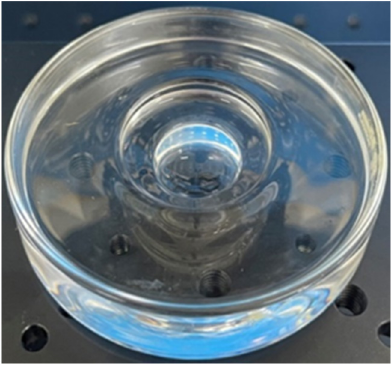
Figure 2. The instability interface.